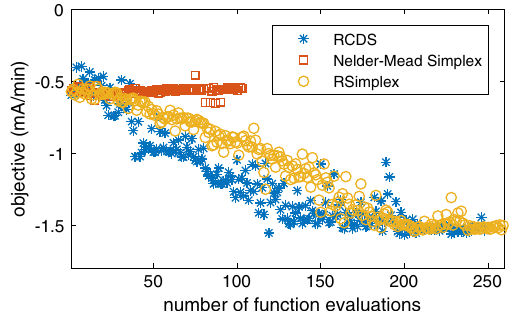
FIG. 5. History of the objective function (which is essentially the beam loss per minute with a negative sign) over the coupling minimization experiment for the three algorithms: RCDS, Nelder-Mead simplex, and RSimplex (w/o simplex